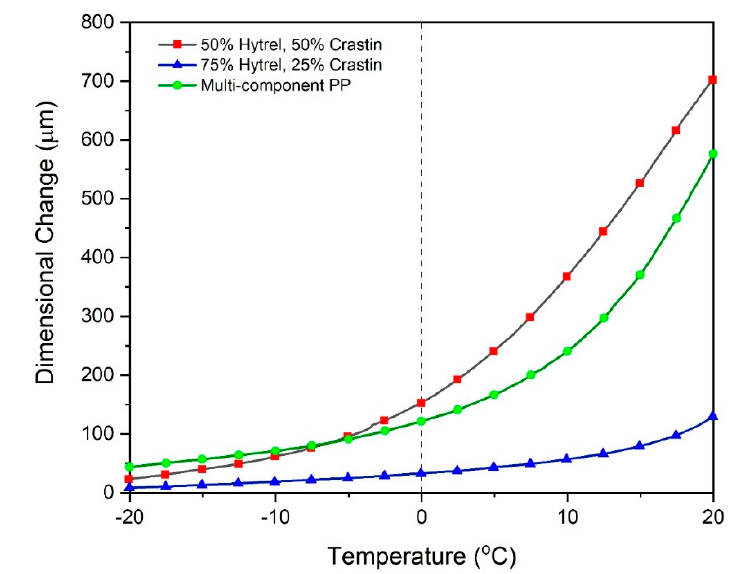
Figure 10. Batting expansion test for bicomponent fibers with compositions 50% Hytrel and 50% Crastin, 75% Hytrel and 25% Crastin, multi-component PP fibers between − 20 °C to 20 °C.